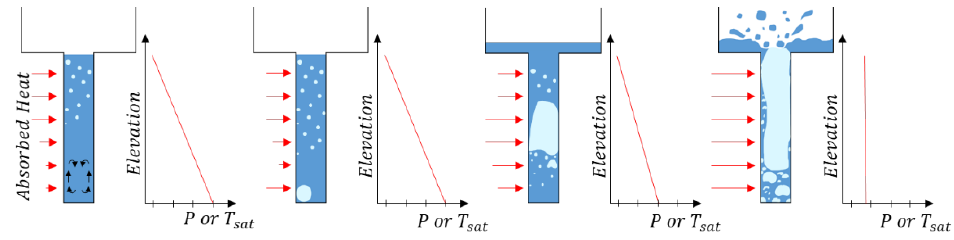
Figure 15. Illustration of geyser boiling in the FHP.